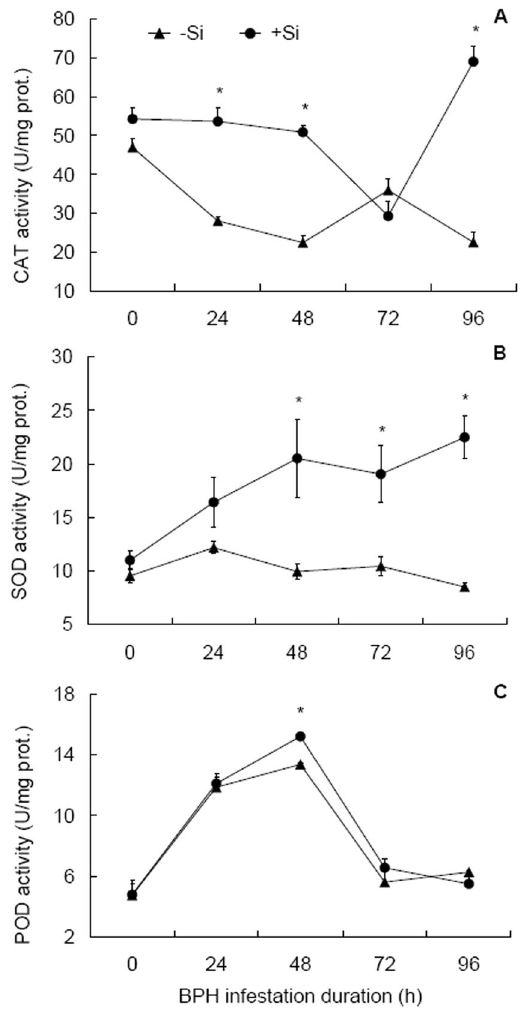
Figure 2. Activities of antioxidant enzymes in rice sheaths in response to Si amendment and BPH infestation. ( A ) Catalase, CAT. ( B ) Superoxide dismutase, SOD. ( C ) Peroxidase, POD. + Si = silicon amendment at 112 mg Si/kg nutrient solution, − Si = no silicon amendment. Error bars represent 1 × SE. n = 3 (biological replicates). * Significant difference between + Si and − Si plants at a certain time post BPH infestation at P < 0.05 via independent samples T